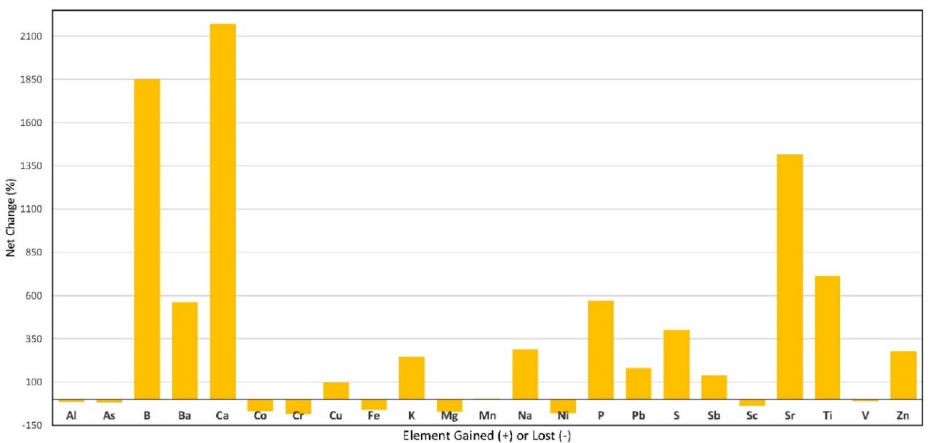
Figure 4. Changes in elemental abundance of ash, topsoil and subsoil of the area studied, based on data in Table S1 and calculations of Tau using Al and Fe as S and using composite of unburned samples.